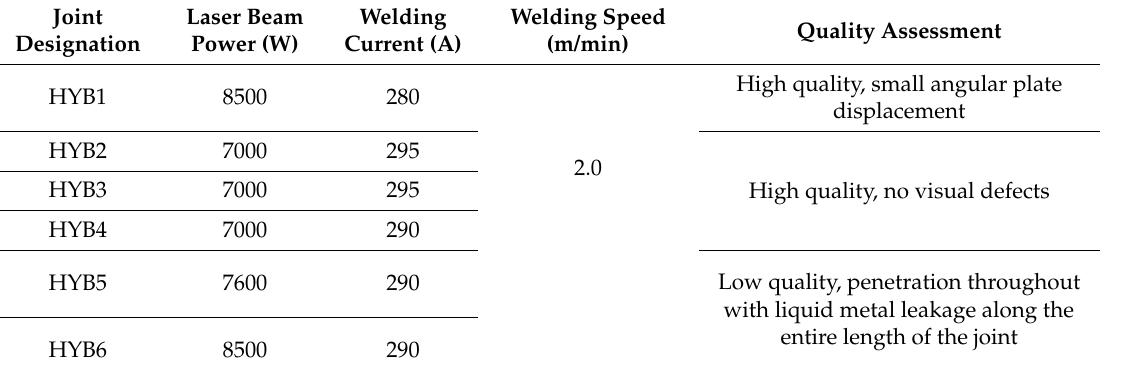
Table 3. Parameters for hybrid laser arc welding (HLAW) (laser beam—GMAW) T-joints. Remarks: gas shielding, argon; gas flow rate, 20 dm 3 /min; preheating drying temperature, 65 ◦ C; arc heat source was placed 4 mm behind the laser beam.